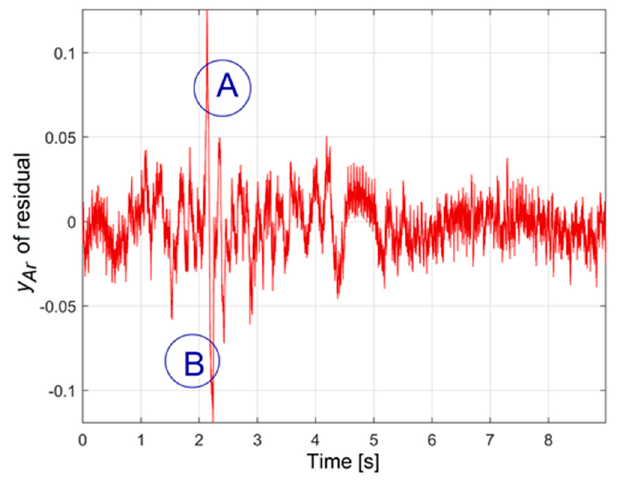
Figure 11. The average evolution y Ar of the residual y r for y -motion.